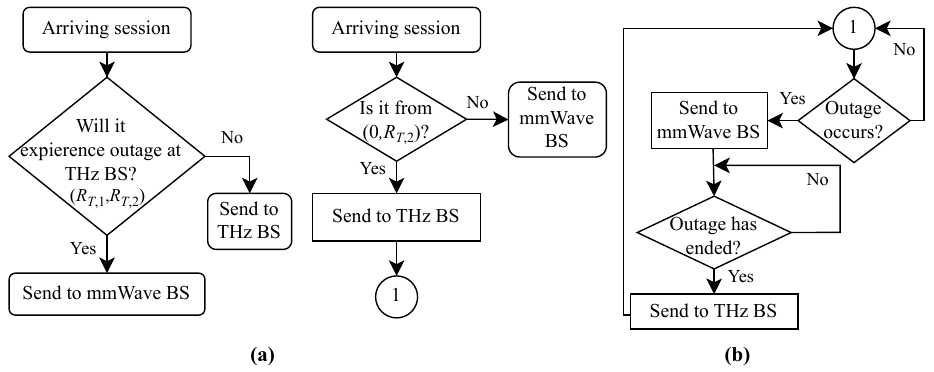
Figure 2. Illustration of the considered association schemes. ( a ) mmWave preferred, ( b ) THz